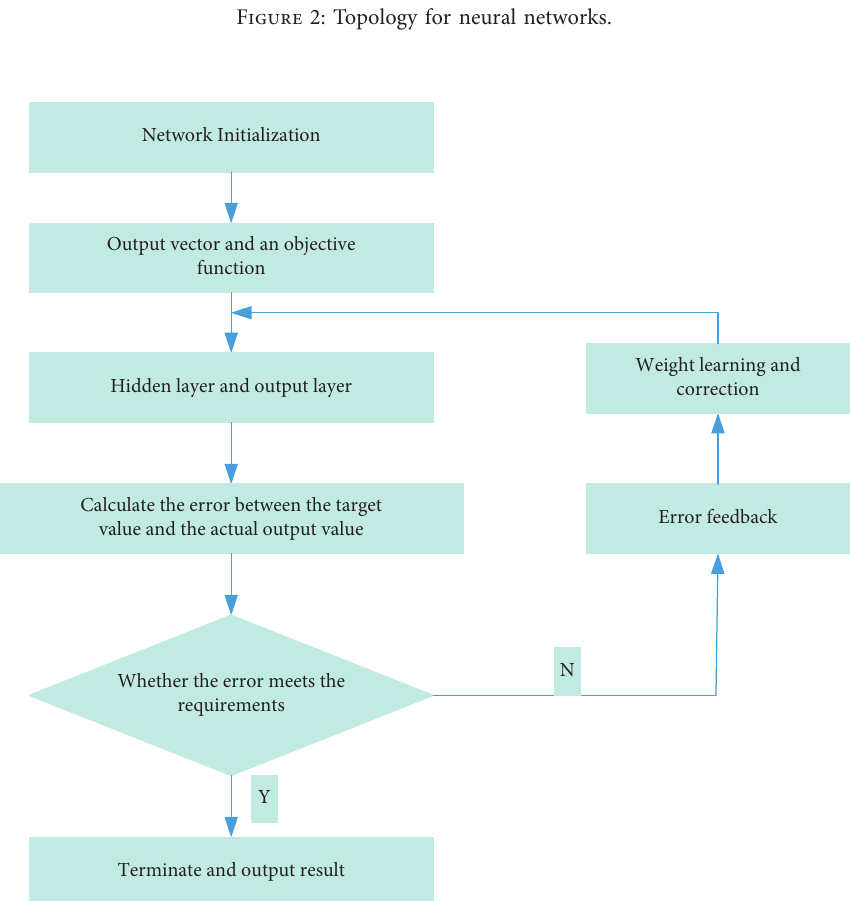
Figure 3: Algorithm